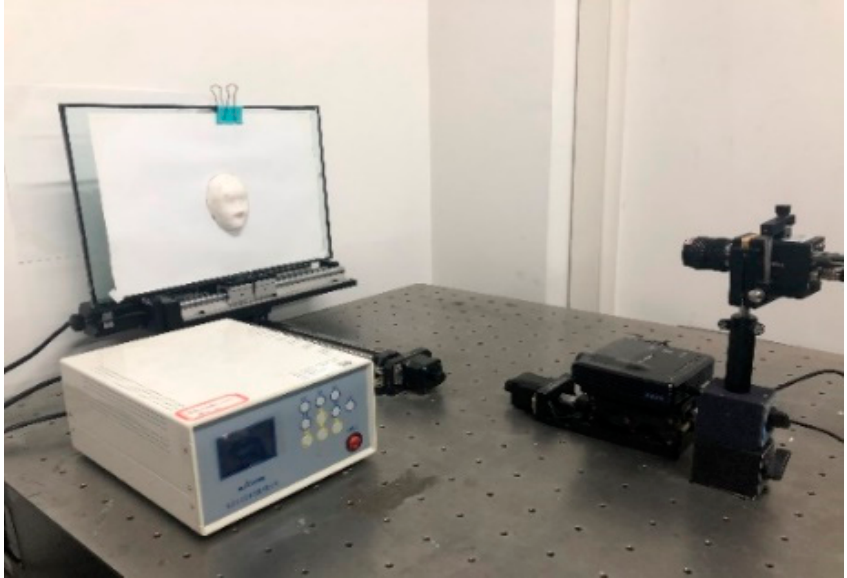
Figure 3. Experimental system.